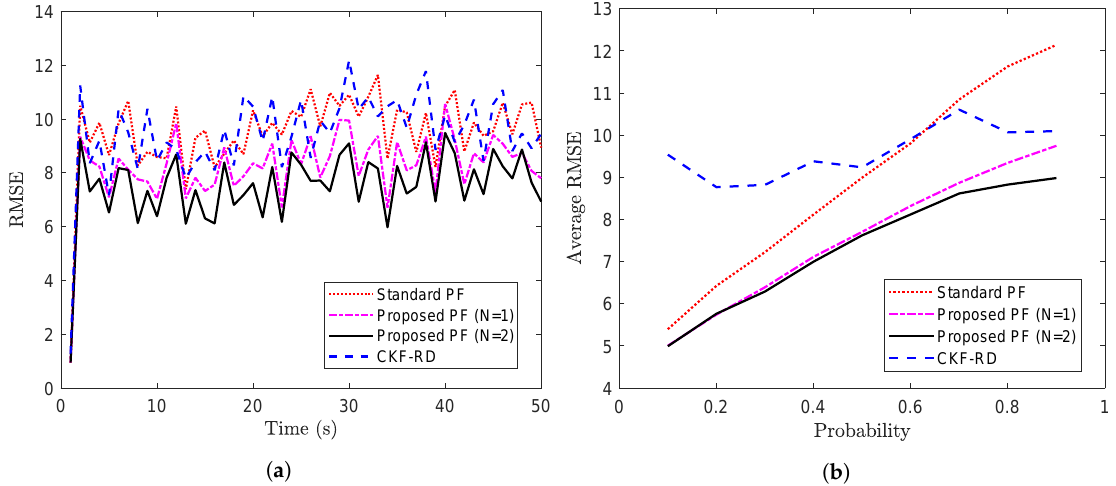
Figure 3. ( a ) RMSE vs. time steps considering p = 0.5 ( b ) Avg RMSE vs. probability (Problem